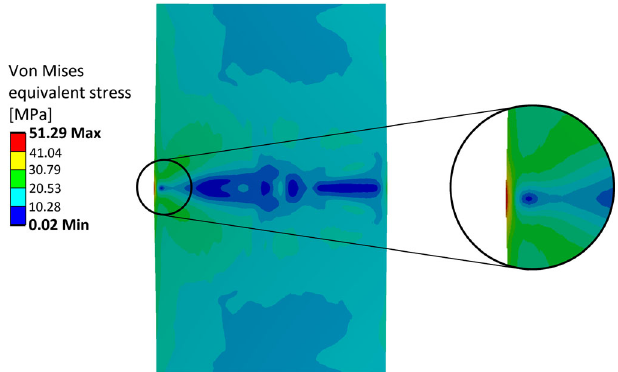
FIG. 14. Von Mises equivalent stress distribution achieved in the first block of the dump core after 136 μ s from the initial NORMGPS beam impact (point C in the graphic in Fig. 13).